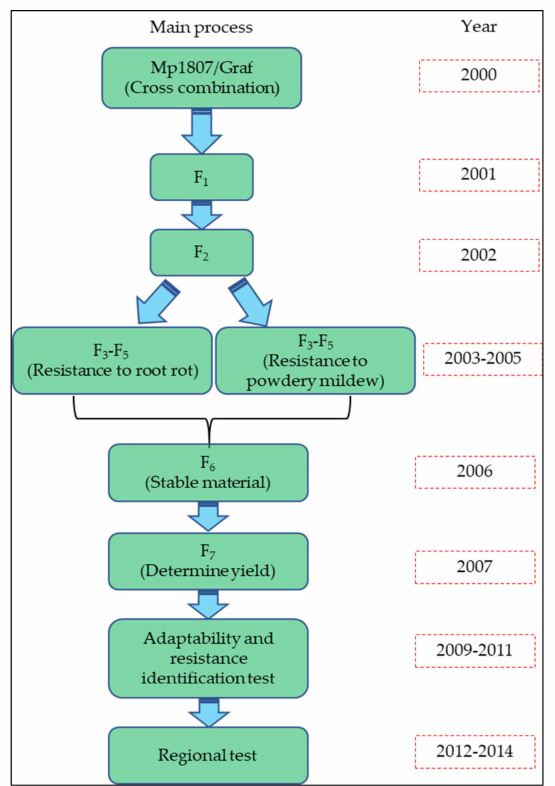
Figure 2. Breeding process of Longwan No.